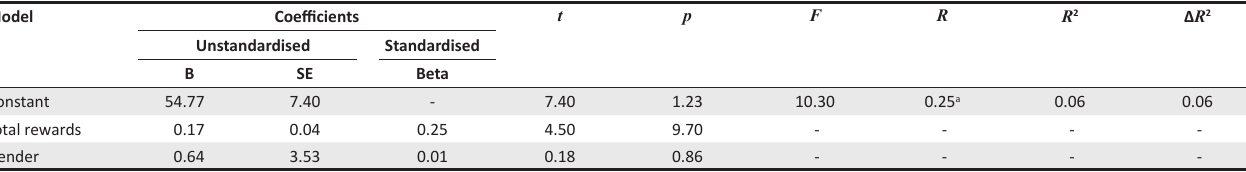
TABLE 8: Moderated regression analysis with gender as moderator between work engagement and total rewards.